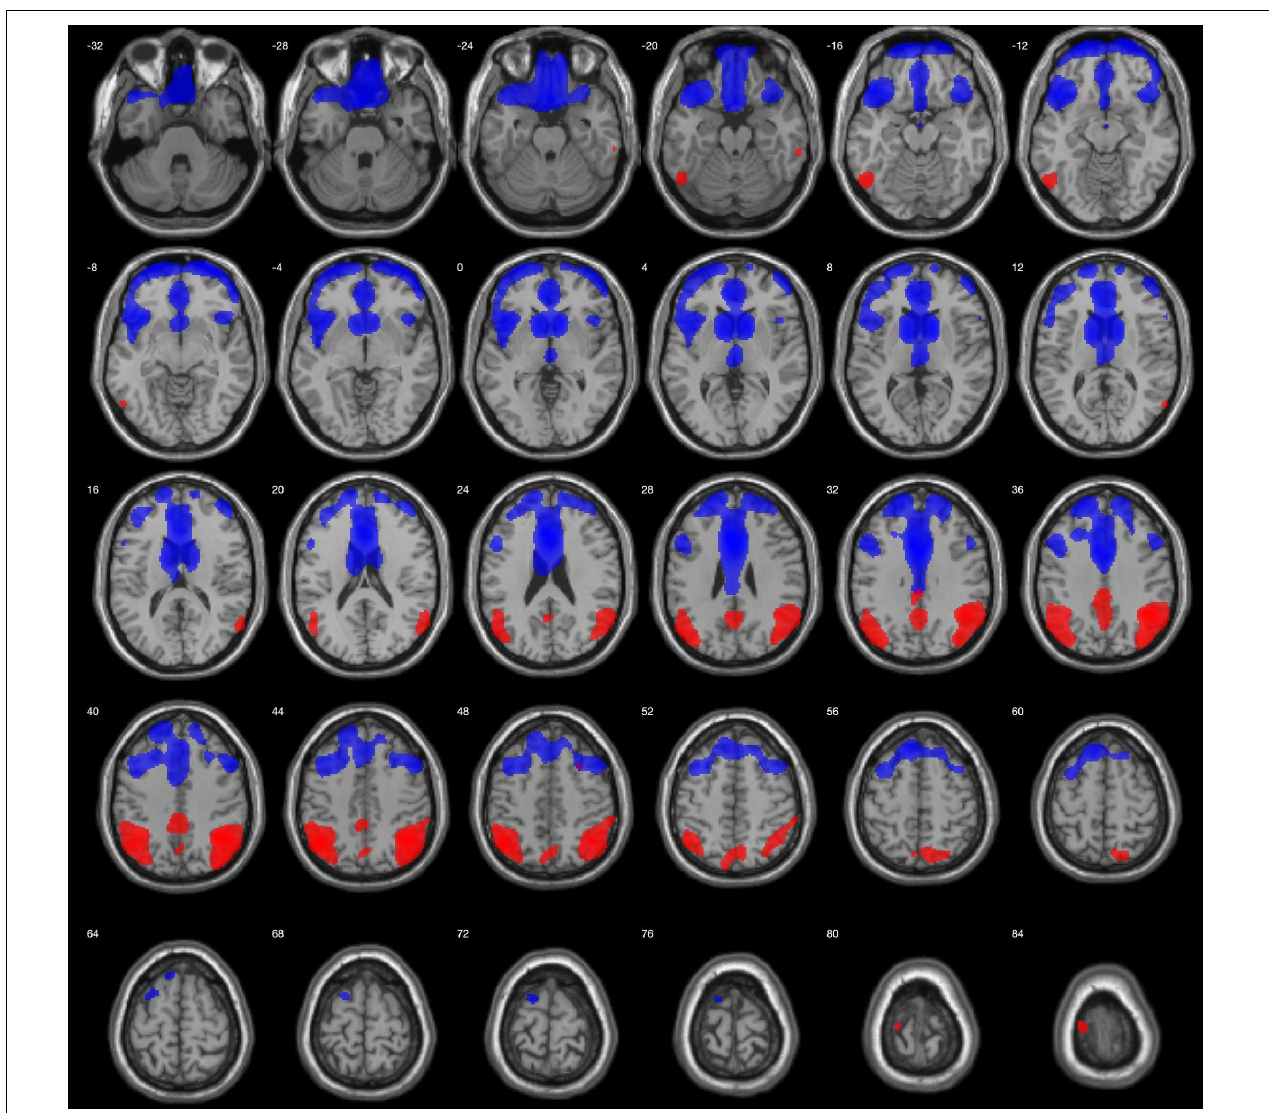
FIGURE 1 | Regions with lower metabolism in the bvFTD group (blue) and AD (red) in comparison to HCs, displayed on MRI template. A 2-sample t -test with a family-wise error corrected p < 0.05 was used. Images are shown using neurological